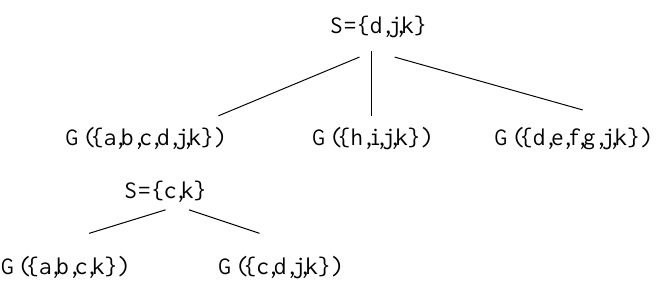
Figure 8. A decomposition of G using Decomposition Step